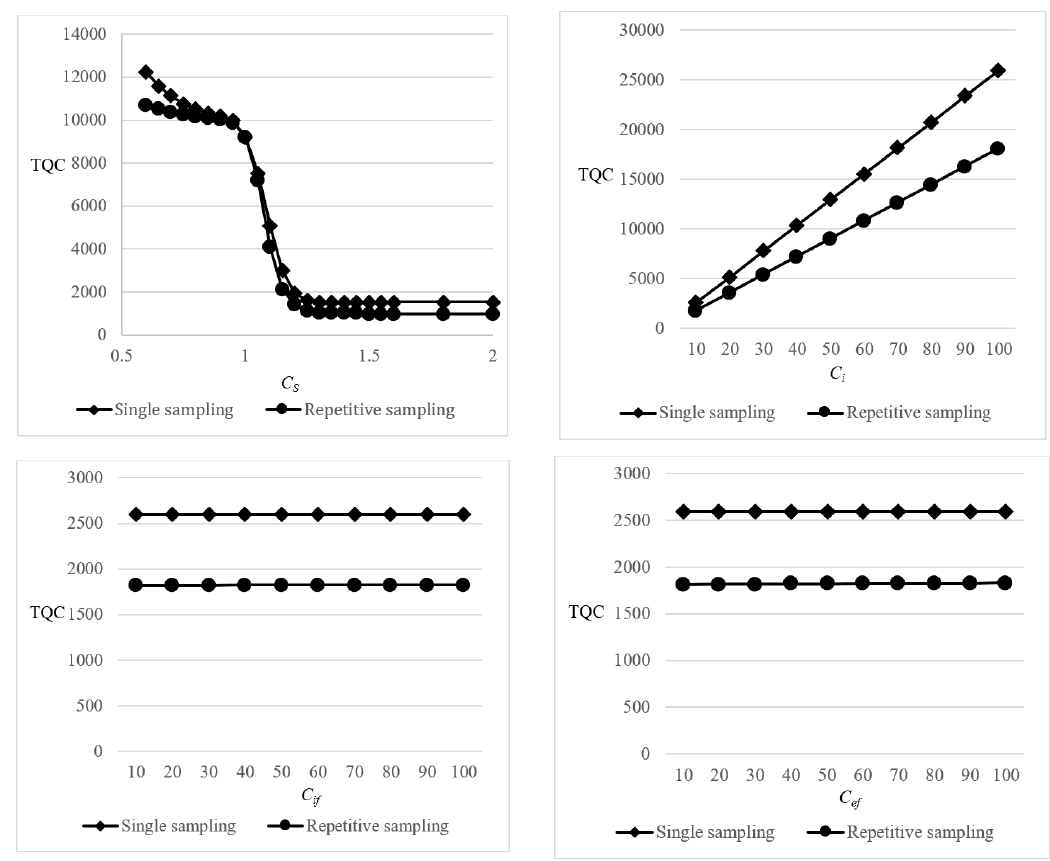
Figure 4. Sensitivity analysis graphs for C S , C i , C if , and C ef.